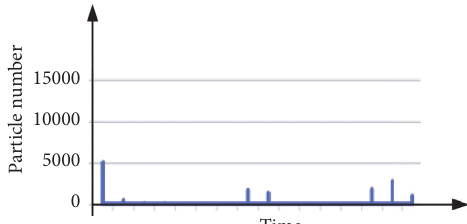
Figure 11: Number of particles generated by stray light trap with 351nm pulse at 1J/cm 2 . The use of fused and AB5 makes the number of particles larger than 0.1 μ m change to 1000 levels (ISO Class 3) even if the stray light of 1J/cm 2 acts, and the stray light control of the system is effective.